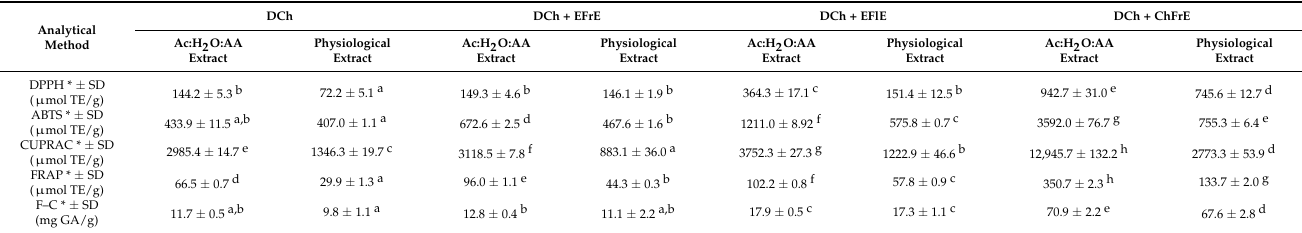
Table 3. Antioxidant capacity and total phenolic content in the investigated chocolates before (Ac:H 2 O:AA extract) and after (physiological extract) in vitro